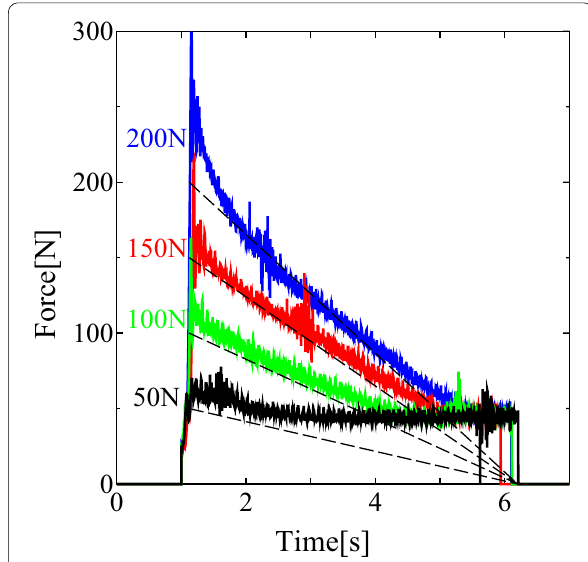
Fig. 15 Force response in initial resistance mode